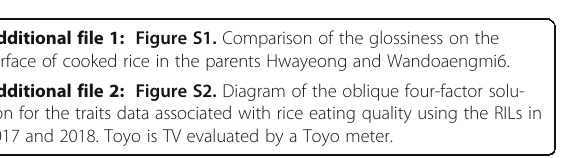
Additional file 1: Figure S1. Comparison of the glossiness on the surface of cooked rice in the parents Hwayeong and Wandoaengmi6. Additional file 2: Figure S2. Diagram of the oblique four-factor solu- tion for the traits data associated with rice eating quality using the RILs in 2017 and 2018. Toyo is TV evaluated by a Toyo meter.